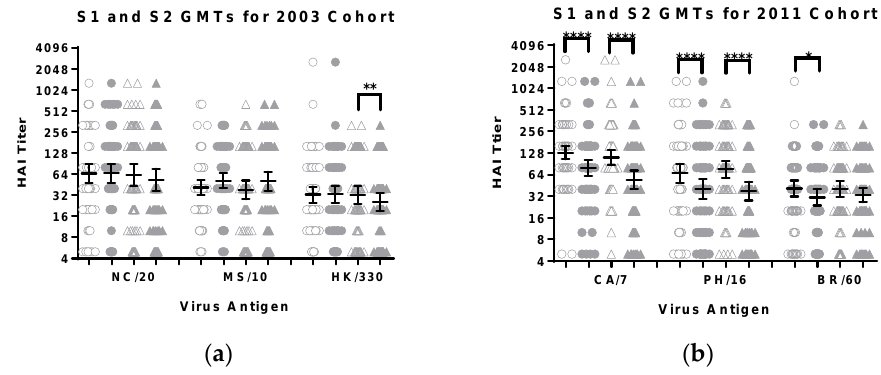
Figure 1. The geometric mean titers, with 95% confidence intervals, for sera samples from the ( a ) 2003 and ( b ) 2011 cohorts are shown. The individual S1 and S2 data points are shown as open and filled symbols respectively, circles for men and triangles for women. The antigens tested with the 2003 cohort were A/New Caledonia/20/1999 (H1N1), A/Moscow/10/1999 (H3N2) and B/Hong Kong/330/2001 (Victoria lineage). The antigens tested with the 2011 cohort were A/California/07/2009 (pdmH1N1), A/Perth/16/2009 (H3N2) and B/Brisbane/60/2008 (Victoria lineage). The difference between male and female titers (S1 or S2) did not reach the level of significance (Mann Whitney test). The difference between the S1 and S2 titers for each group was evaluated using the Wilcoxon matched-pairs rank test and the p -values are shown: *, p ≤ 0.05; **, p ≤ 0.01; and ****, p ≤ 0.0001.